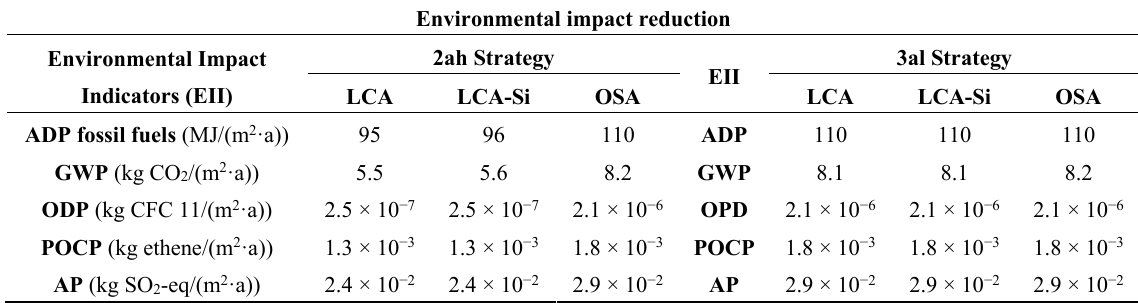
Table 10. Results of the analysis for other impact indicators expressed for m 2 and year. For abbreviations, refer to Table